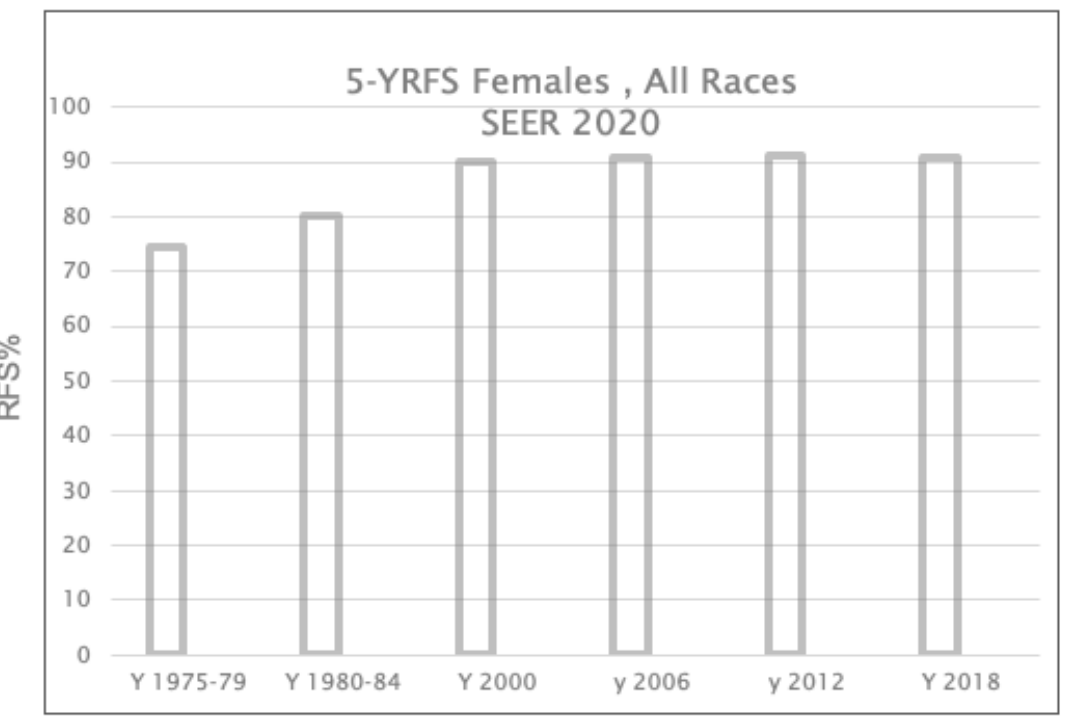
Figure 1. SEER 2020 5-year Relative Free Survival (RFS)% by year of diagnosis; all races; females; 5-year RFS.